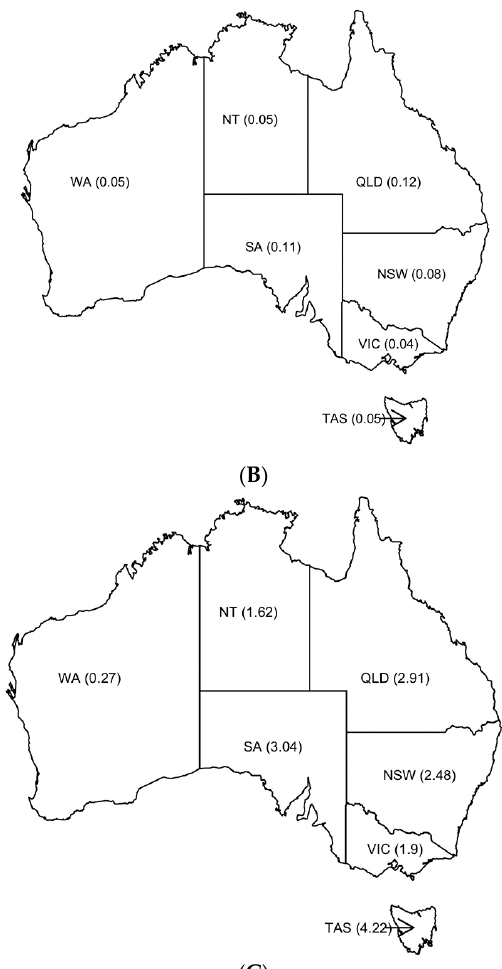
Figure 4. Numbers per capita (1000) of total ads for relinquished cats on Gumtree ( A ) and PetRescue ( B ) from 9 to 26 February 2016, and RSPCA shelter admissions ( C ) for each Australian State/Territory. The prices of advertised cats on Gumtree in each State/Territory were compared using three categories: $AUS0, $AUS1–499 and >$AUS500. The data for the ACT, NT, and Tasmania were not included as there were insufficient cases per category. There was a significant difference in price category between states χ ²(8) = 38.6, p < 0.0001. The highest proportion of free cat ads came from Victoria (77%) and SA (67%) with the lowest proportion of free ads in WA (54%; Table 6). Victoria had a lower proportion of Gumtree ads for cats $AUS1–499 (16% vs. >30% for other States), and the highest proportion of ads for cats costing >$AUS500 (7%). The proportions of Gumtree ads for cats >$AUS500 was low overall (3–7%).